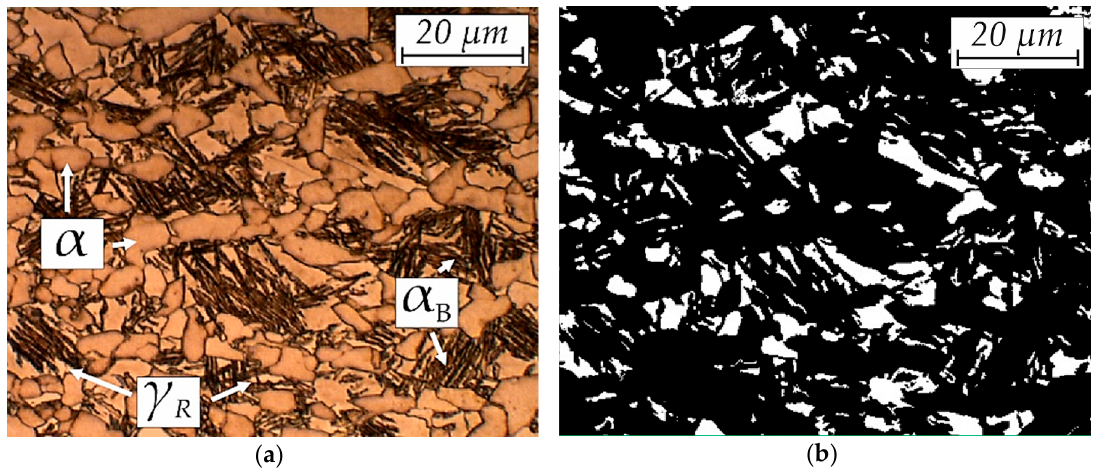
Figure 5. Initial microstructure of the investigated steel: ( a ) optical micrograph and ( b ) binary map of retained austenite (marked as white).